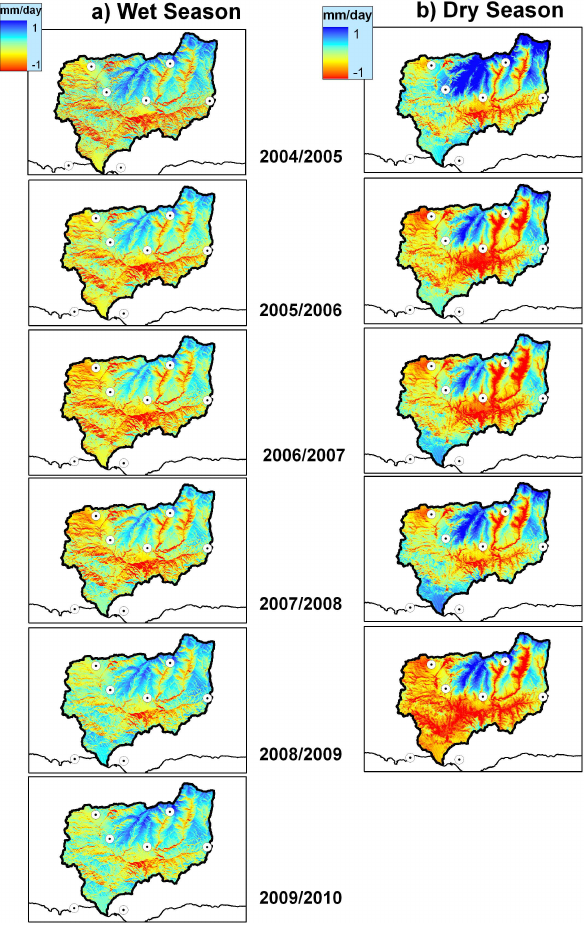
Fig. 7. Differences between ET 0 obtained by ASCE-PM and Hargreaves with adjusted coefficient interpolated by IDW at the Guadalfeo river